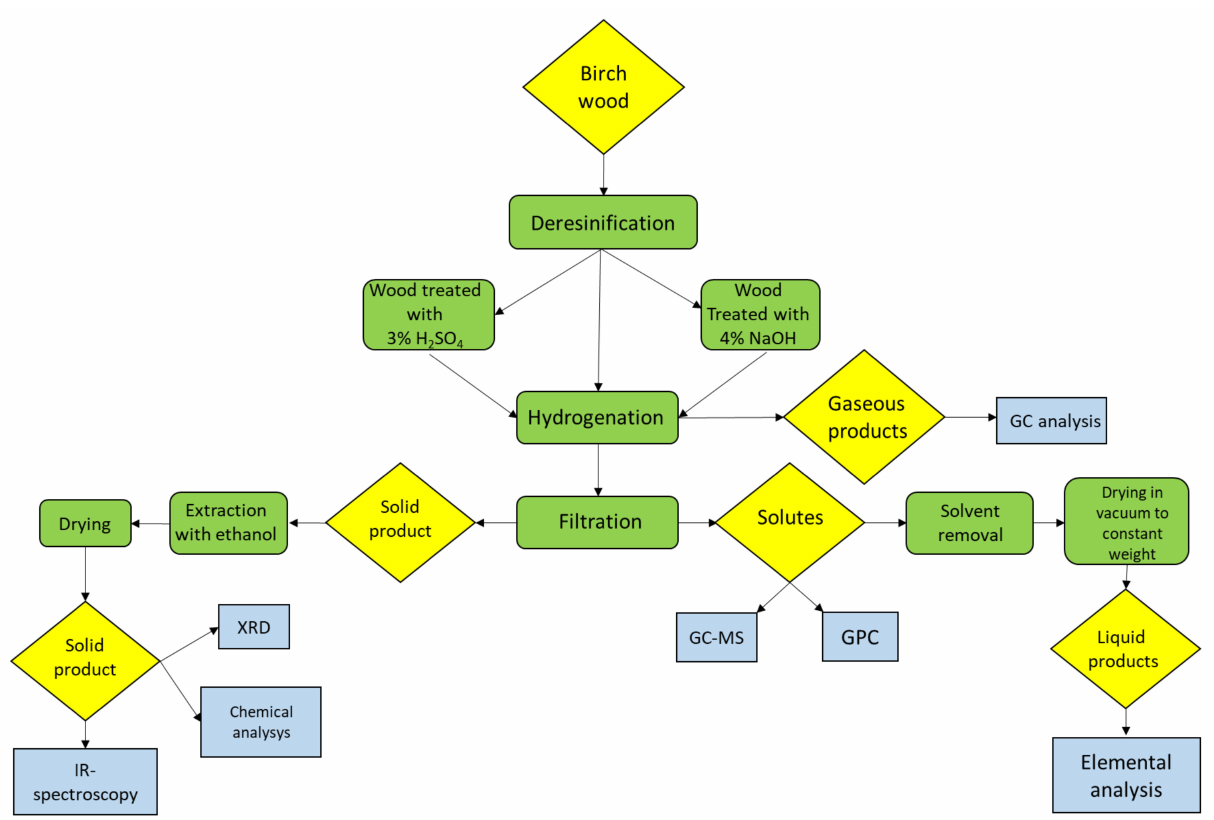
Figure 9. Scheme of birch wood hydrogenation and analysis of the products. A rotary evaporator was used for removing the solvent from the soluble products. The liquid products were dried to constant weight in vacuum (1 mm Hg) at room temperature. The solid product was washed with ethanol until the solvent discoloration and dried to constant weight at 80 ◦ C. The yields of liquid ( α 1 ), solid ( α 2 ), gaseous ( α 3 ) products